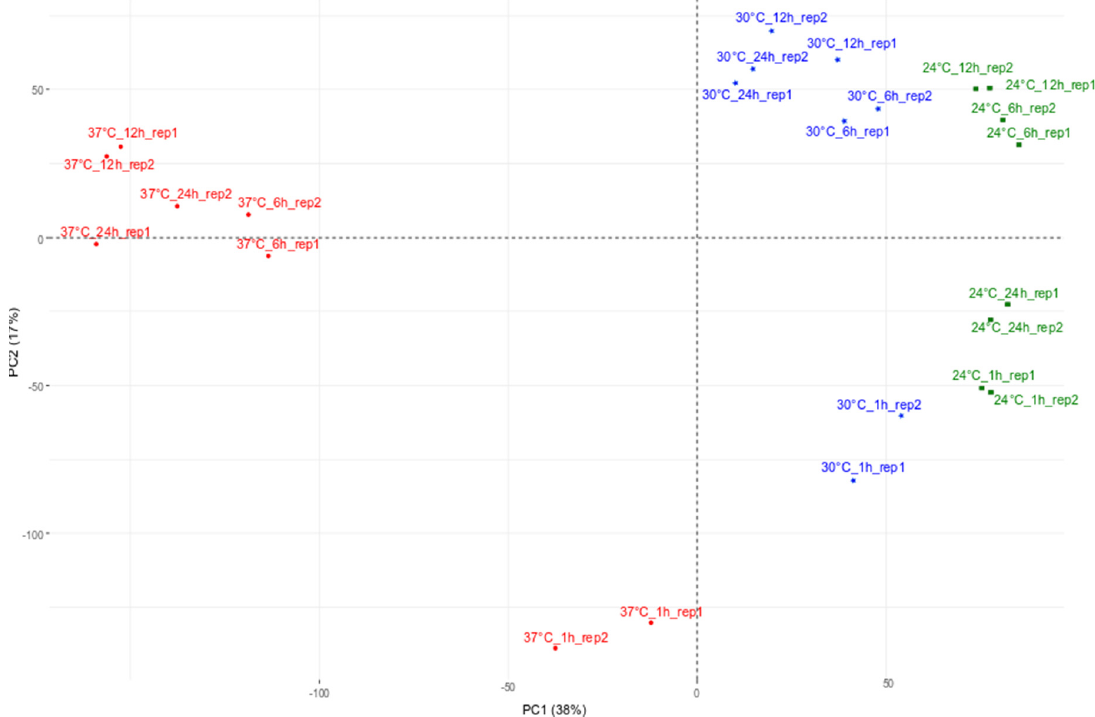
Figure 1. Plot showing the first two components of the principal component analysis (PC1 and PC2) representing the transcriptome of P. patens plants grown under heat treatments (30 °C in blue and 37 °C in red) and control conditions (24 °C in green) at 1, 6, 12 and 24 h. As an example: “24°C_1h_rep1” corresponds to the first replicate of the treatment at 24 °C after 1 h.